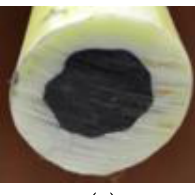
Figure 4. Schematic diagram of ultrasonic array detection.